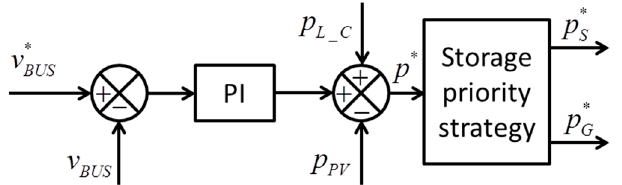
Figure 12. Control loop without DCE.